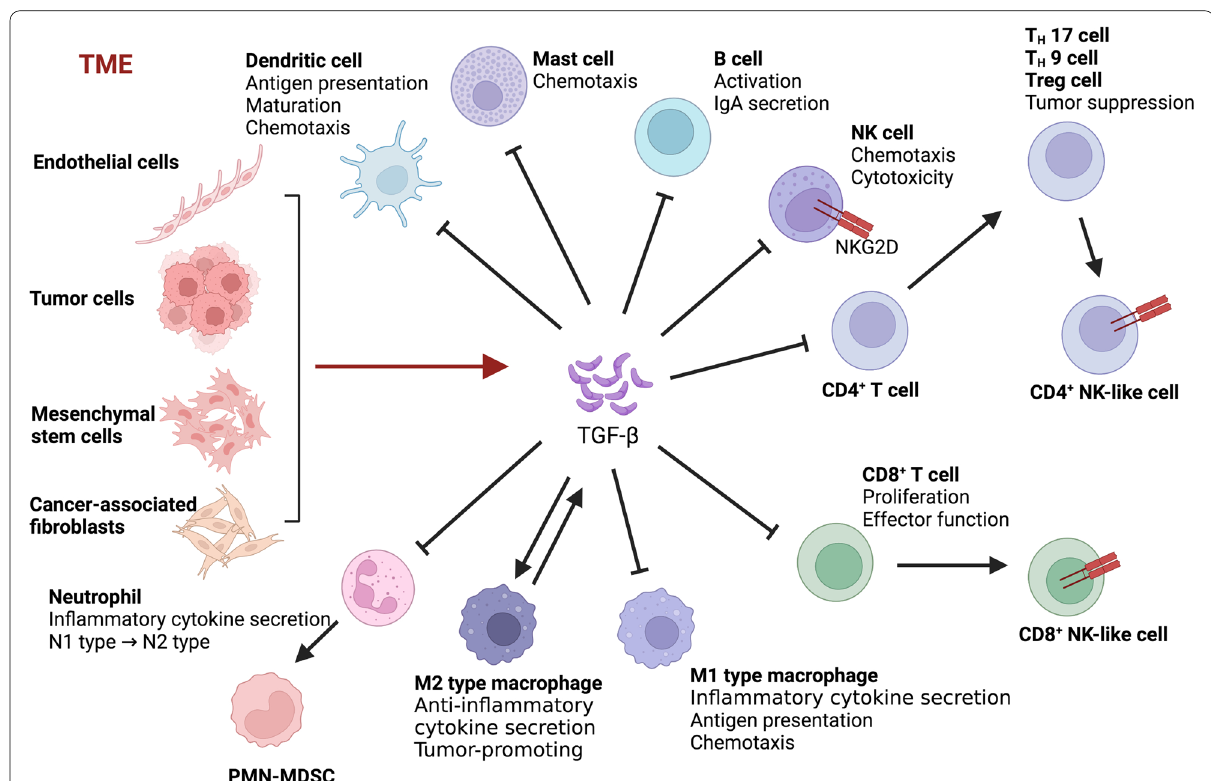
Fig. 3 The functions of TGF-β in the TME. Tumor cells, endothelial cells, mesenchymal stem cells, cancer-associated fibroblasts, and macrophages can induce the production and secretion of TGF-β in the TME. TGF-β suppresses tumor immune responses by modulating the multiple functions of immune cells in the TME, as